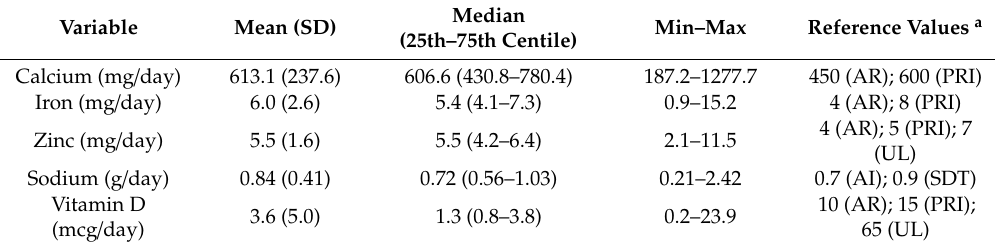
Table 9. Daily dietary intake of minerals and vitamin D in infants / children aged 1 ≤ years < 4 ( n = 148) † .